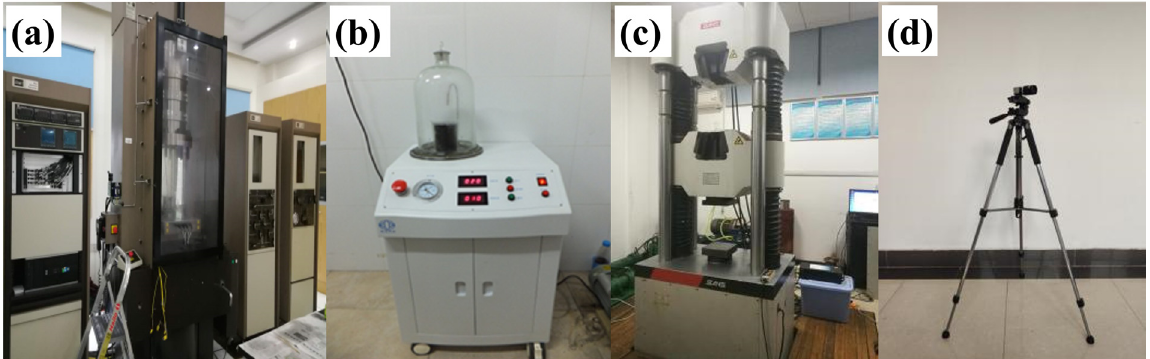
Figure 1. Experimental equipment. ( a ) MTS815 testing machine for 2000 KN; ( b ) rock water-saturation equipment; ( c ) uniaxial compression rigidity testing machine; ( d ) DSCM acquisition system.